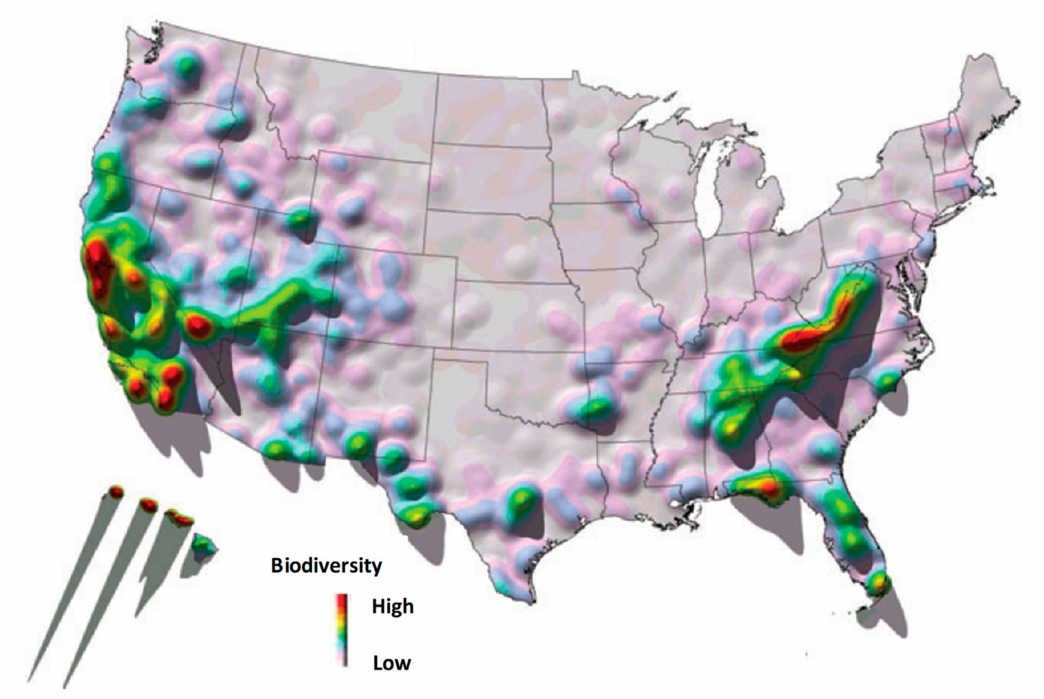
Figure 2. Carbon sequestration potential of the region. Areas of biological diversity in the continental United States identify the Southern Application Forest Region as a critical zone (Source: The Nature Conservancy, Arlington, VA,